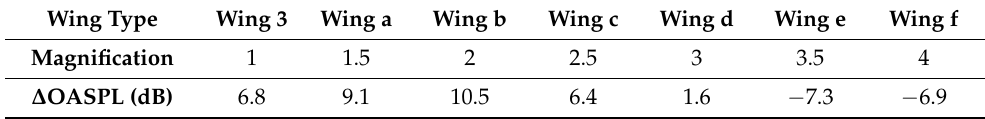
Table 5. Overall sound-pressure-level reduction for different bionic